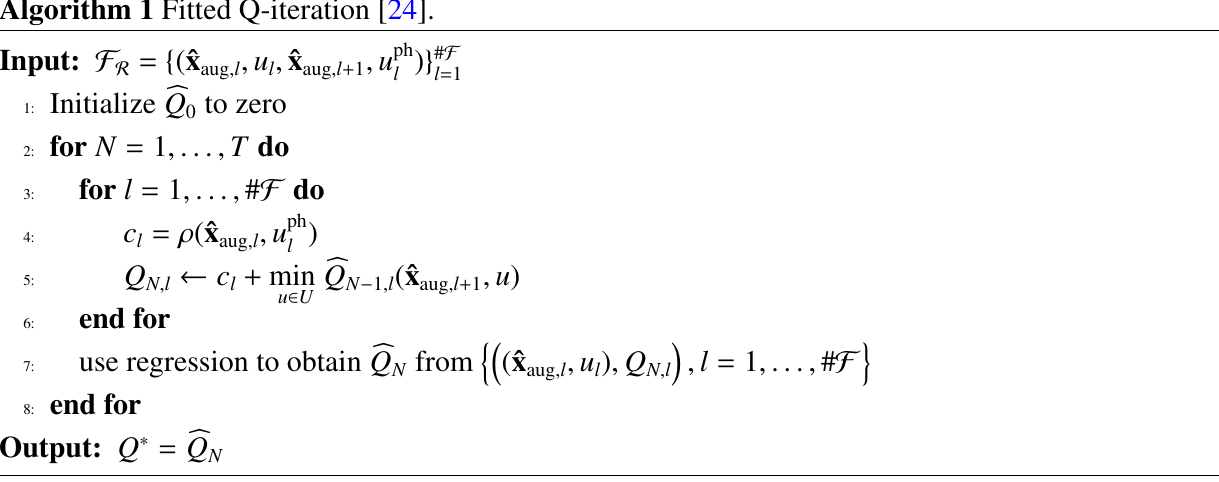
Algorithm 1 Fitted Q-iteration